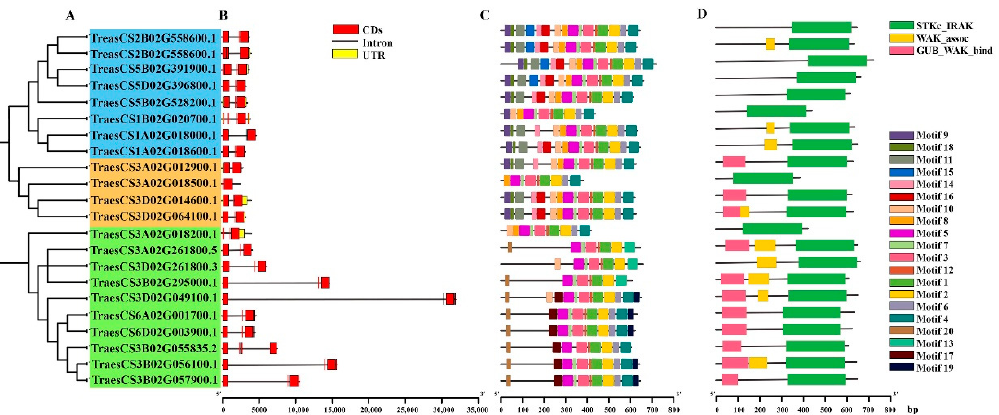
Figure 1. Phylogenetic tree, gene structure, motif, and domain analyses. ( A ) Phylogenetic tree constructed on MEGAX using NJ method (1000 replications) representing three groups I (blue), II (orange), and III (green). ( B ) Exon, intron, and UTRs analyses performed on GSDS 2.0. ( C ) Conserved motifs identified with MEME tool. Each motif is shown with different color, as demonstrated in the legends. ( D ) Conserved domains identified using SMART tool. Green rectangle represents the S_TKc domain, pink shows the GUB_WAK_bind domain, and yellow indicates the WAK_association